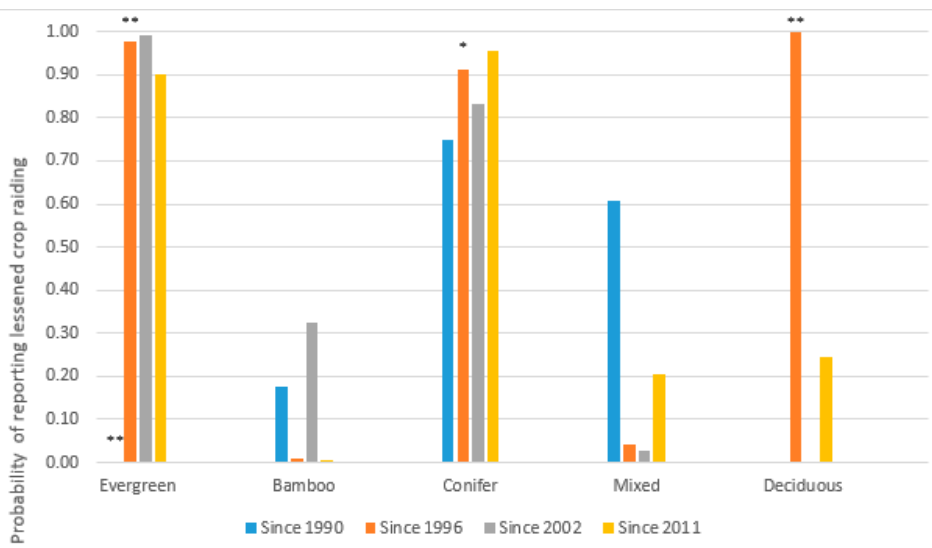
Figure 7. Probability of reporting crop raiding as “serious” or “very serious” by vegetation and two plausible boar densities (* p < 0.05; ** p < 0.01).